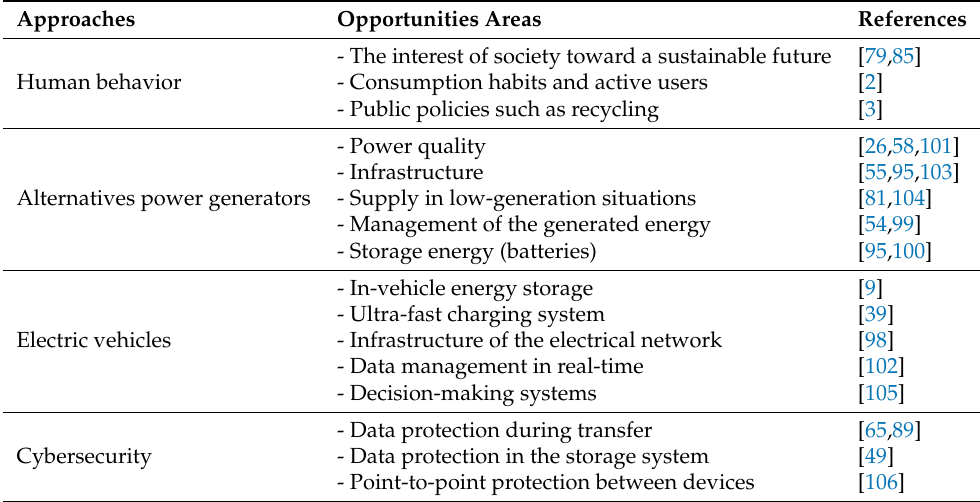
Table 3. Challenges that are currently important for smartification.